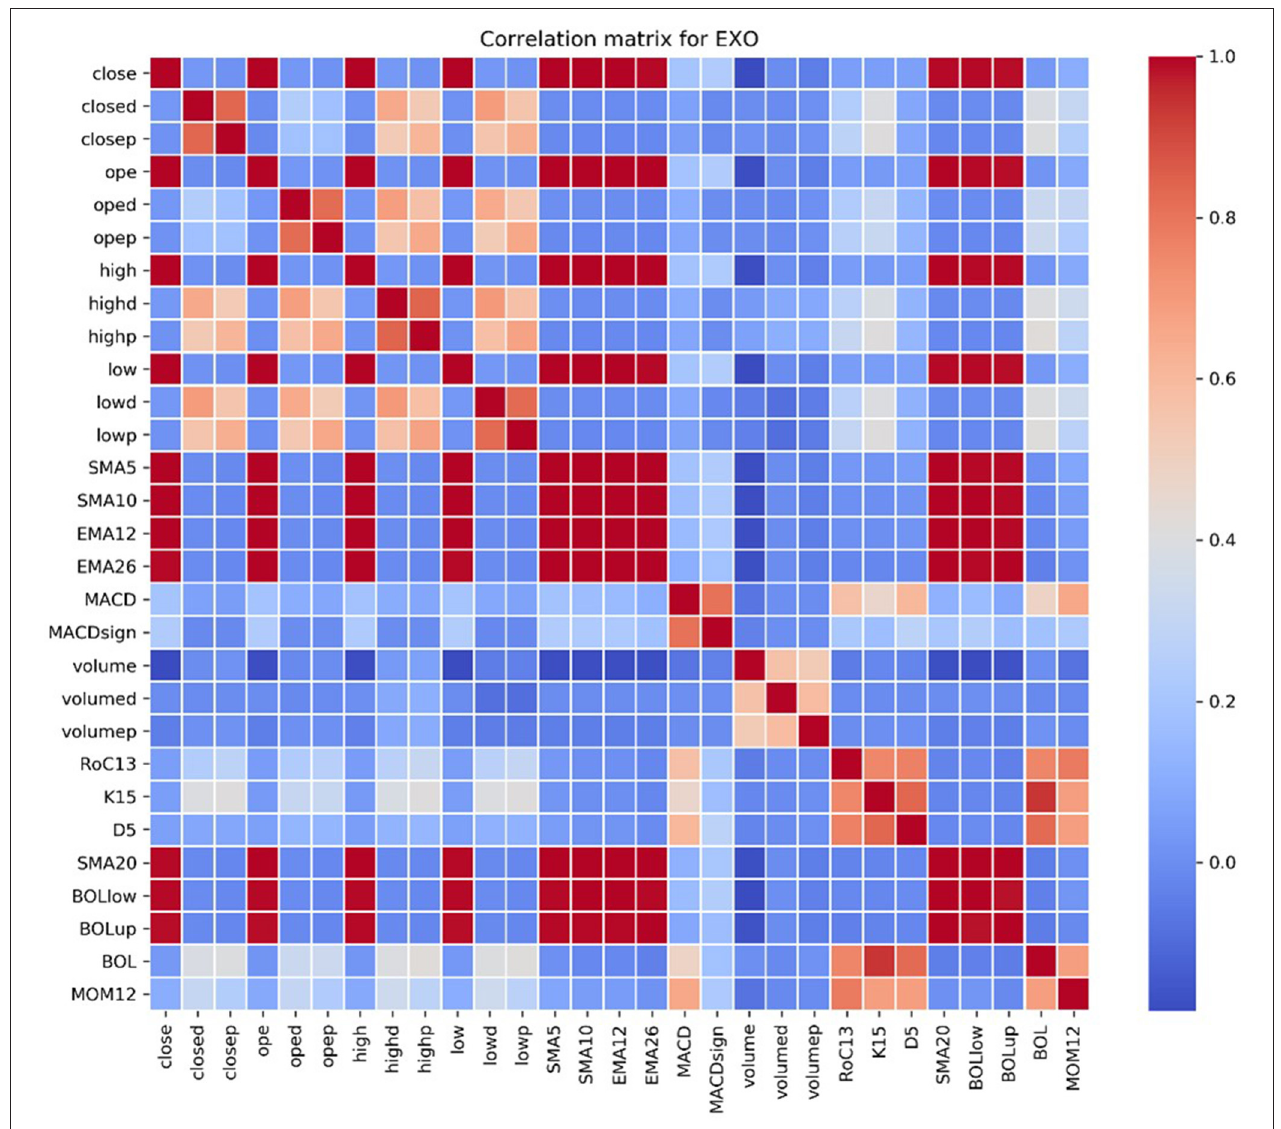
FIGURE 3 | Correlation matrix for EXO of the considered technical